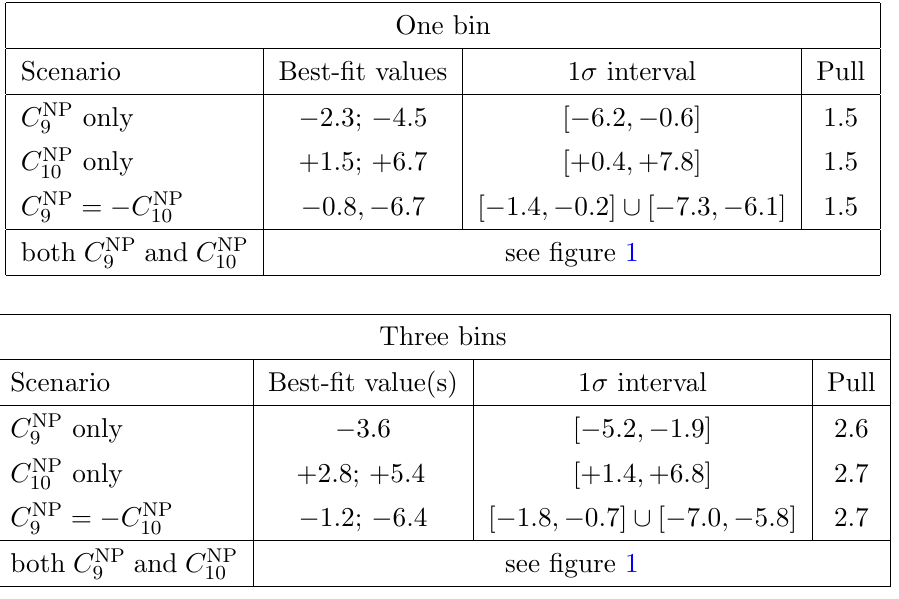
Table 1 . Estimated 1 (cid:27) ranges of the NP coe(cid:14)cients C NP refers to the bin [1 (cid:0) 6] GeV 2 , and \three bins" includes [2 (cid:0) 4] GeV 2 , [4 (cid:0) 6] GeV 2 and [6 (cid:0) 8] GeV 2 . Pull is de(cid:12)ned as a square root of the di(cid:11)erence of (cid:31) 2 values between the best-(cid:12)t and SM points: p pull = (cid:31) 2 (cid:0) (cid:31) 2 min SM